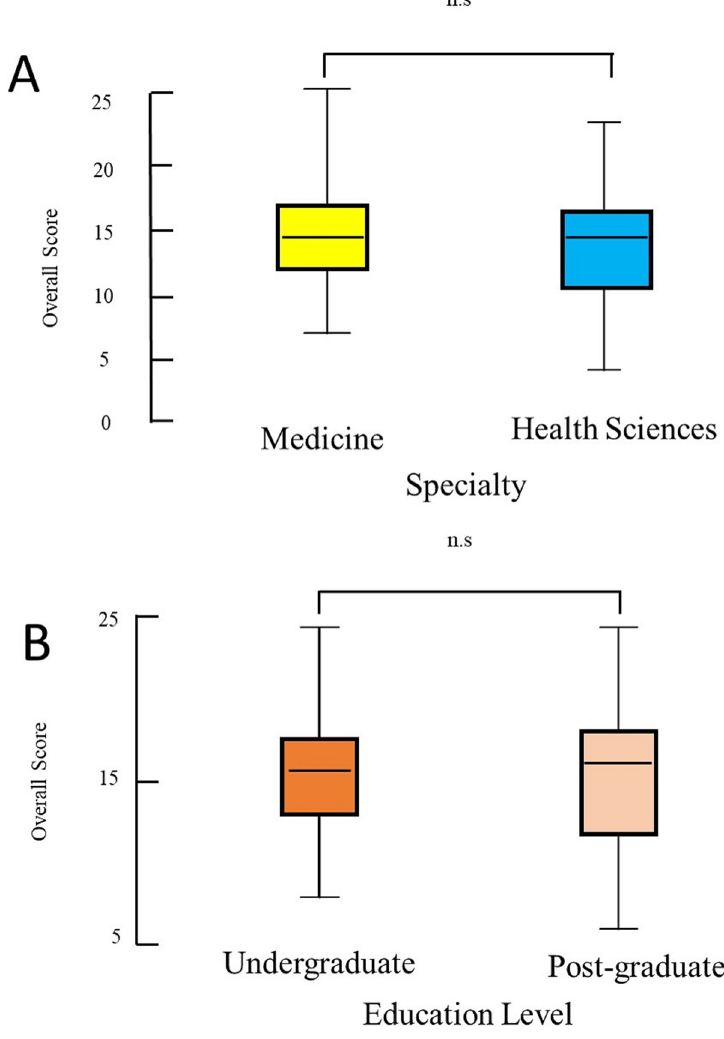
Fig 2. Box-and-whiskers plot of overall score of practices towards COVID-19 comparing medical students with allied health students (A) and undergraduate students with postgraduate students (B). The box represents the 25th to the 75th percentile IQR. The horizontal line within each box represents the median, ns = non